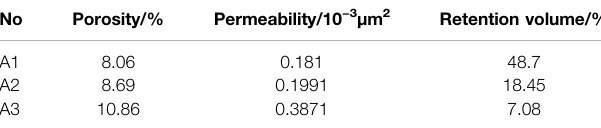
TABLE 3 | Surfactant solution retention volume after imbibition